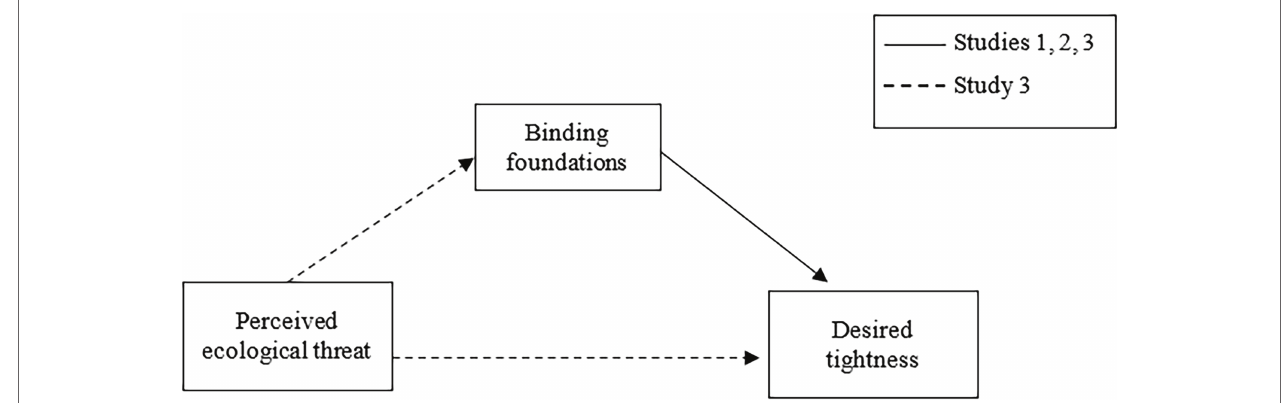
FIGURE 1 | Hypothetical model of the